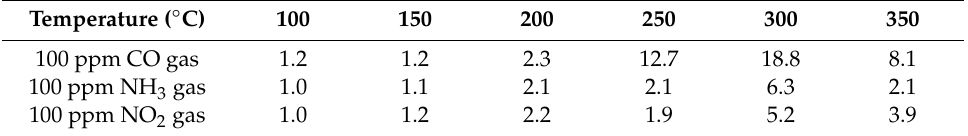
Figure 11. Response of ZnO NW vines decorated with 0.05 M α -Fe 2 O 3 to 100 ppm CO, NH 3 , and NO 2 : ( a ) according to temperature from 100 to 350 °C, ( b ) at 100 °C. Table 3. Response of ZnO NW vines decorated with 0.05 M α -Fe 2 O 3 at various temperatures.